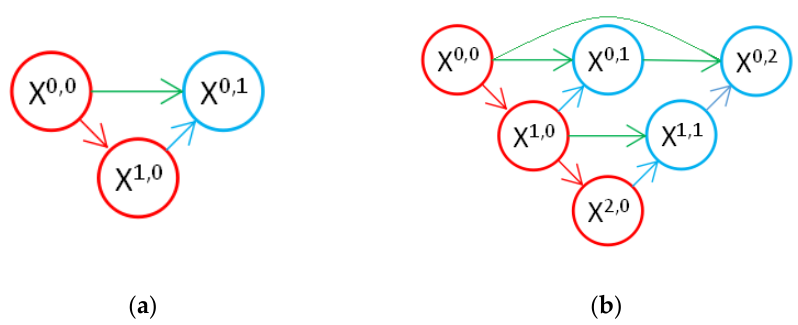
Figure 4. Structure diagrams with both the first layer L 1 and the second layer L 2: ( a ) L 1; ( b ) L 2.